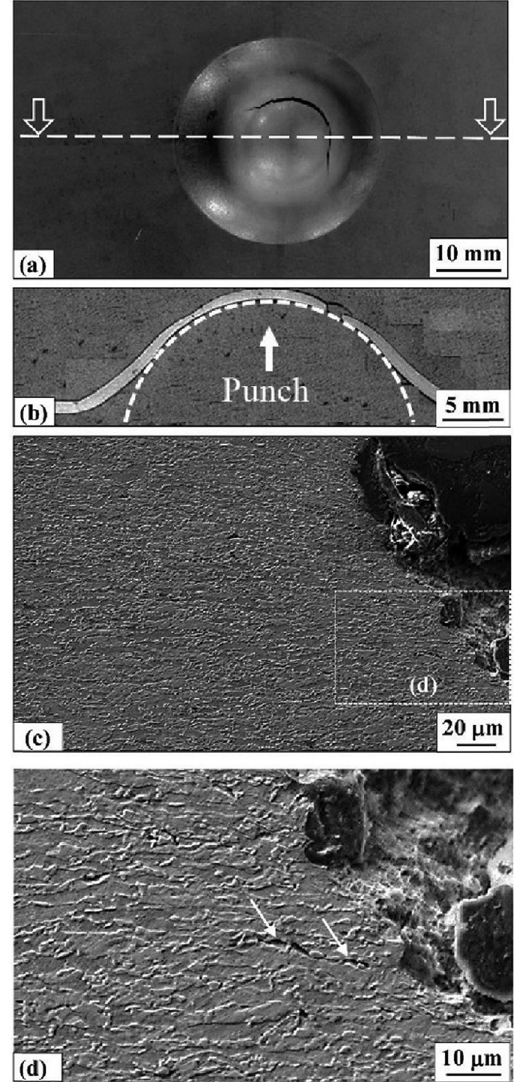
Figure 5: ( a ) Top macro - view, ( b ) cross - sectional macro - view, and ( c ) and ( d ) fracture zone microstructure of the AR cupping test specimen.